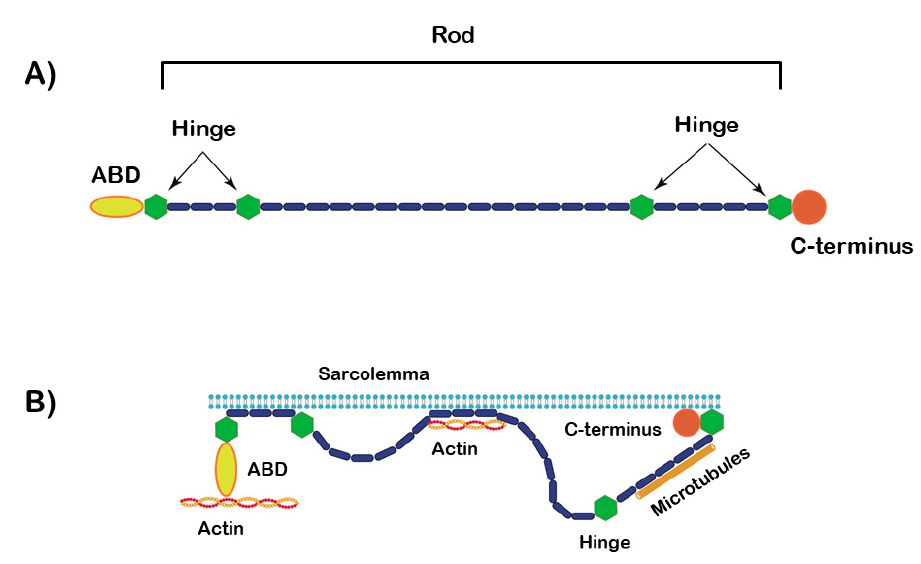
Figure 4. ( A ) Schematic diagram illustrating the molecular organization of dystrophin. Relevant regions/domains, including actin-binding domains (ABD), are highlighted. ( B ) shows dystrophin bonded to actin.